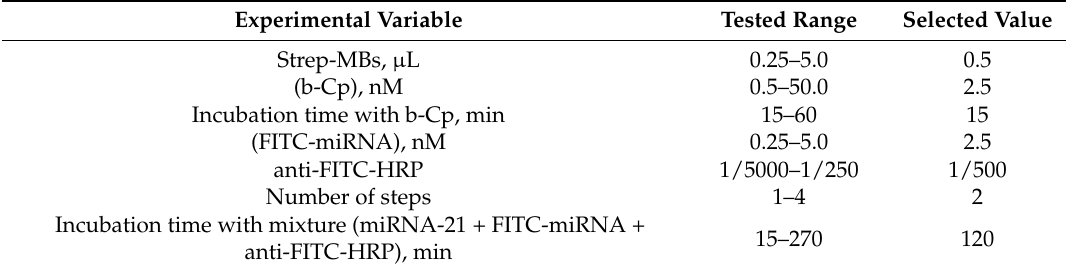
Table 2. Optimization of the experimental variables affecting the performance of the amperometric biosensor developed for miRNA-21